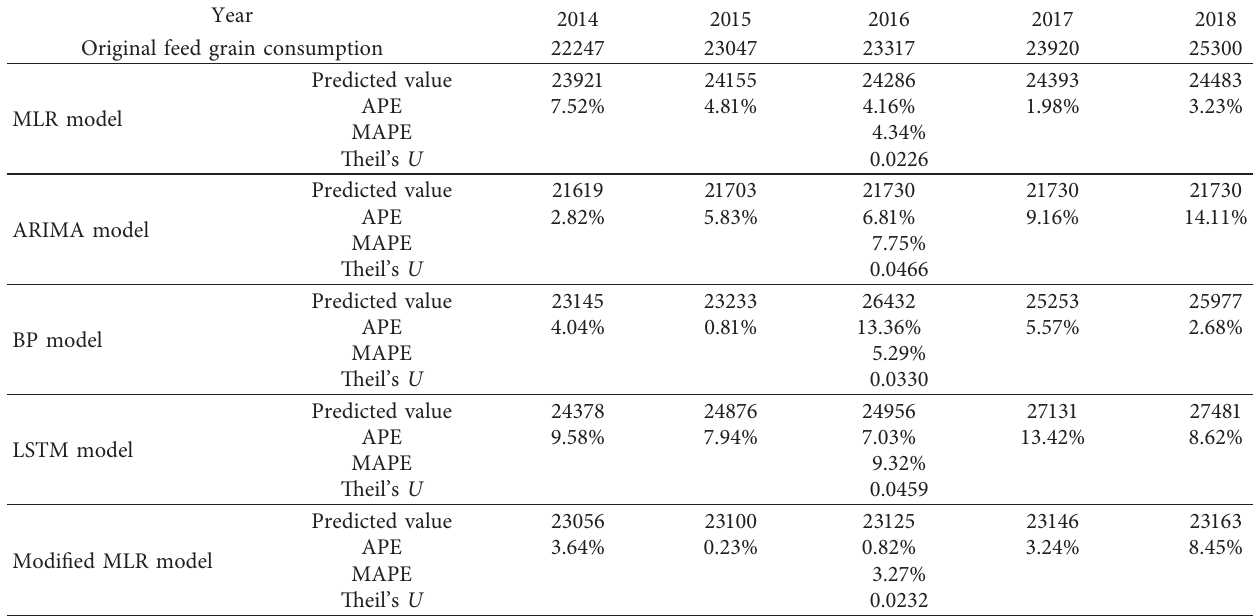
Table 4: Comparison of feed grain consumption prediction results in China (2014–2018) (unit: ten thousand tons).